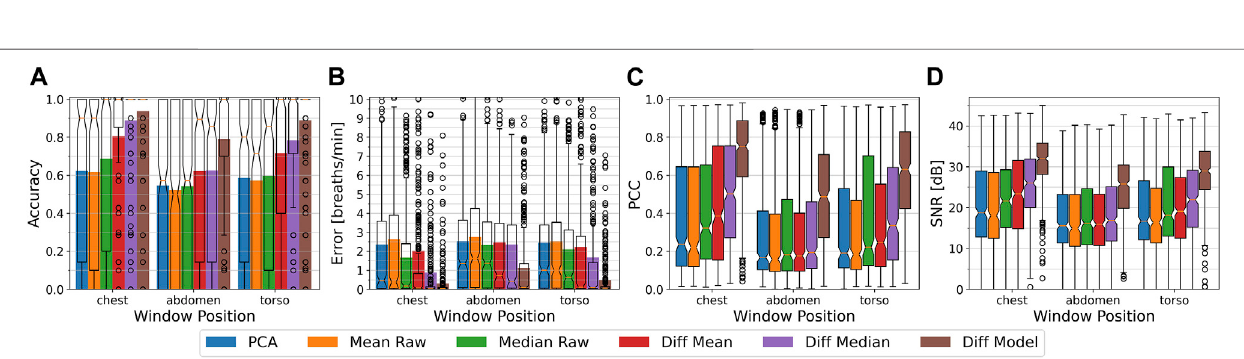
FIGURE5| From (A – D) :Therespiratoryrateaccuracy,errorsinbreathperminute,PearsonCorrelationCoef fi cientw.r.t.thegroundtruthsignal,andsignaltonoise ratio of the different methods. Plots are separated by the chest, abdomen, and torso region with all conditions (sitting, standing upright, and occlusion), distances (1 – 4 m),andrespiratoryrates(10and15 bpm)combined.AccuracyanderrormetricsuseaFastFourierTransformwindowwithalengthof48 s.Thecoloredbarsshow the averages, while overlay box plots show median (middle parts) and whiskers marking data within 1.5 IQR. All algorithms perform best on the chest region, while the abdomen especially for the difference based methods causes high performance